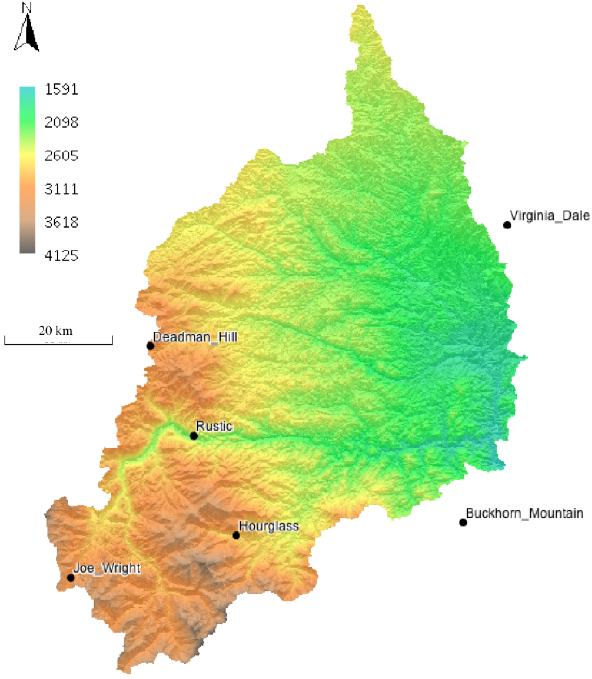
Fig. 3. Cache la Poudre River basin digital elevation model. Eleva- Figure3. CachelaPoudreriverbasindigitalelevationmodel.Ele- vationsareinmeters. tions are in